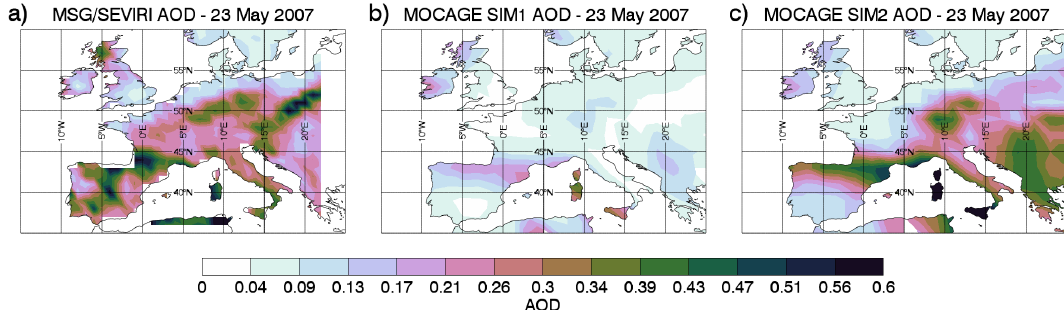
Figure 8. Aerosol optical depth fields over Europe for 23 May 2007 at 550nm from SEVIRI (a) , SIM1 (b) , and SIM2 (c)